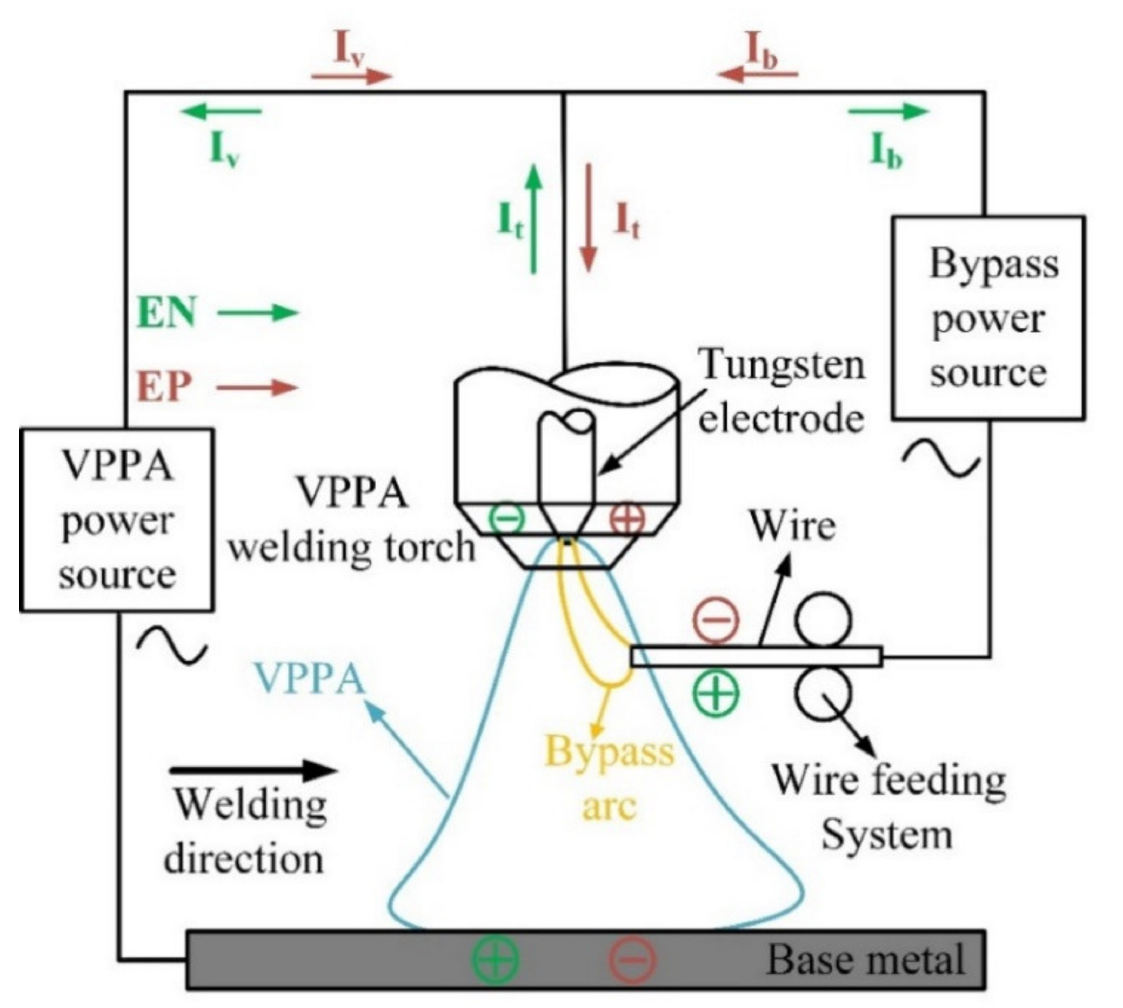
Figure 1. Schematic diagram of bypass coupled variable polarity arc